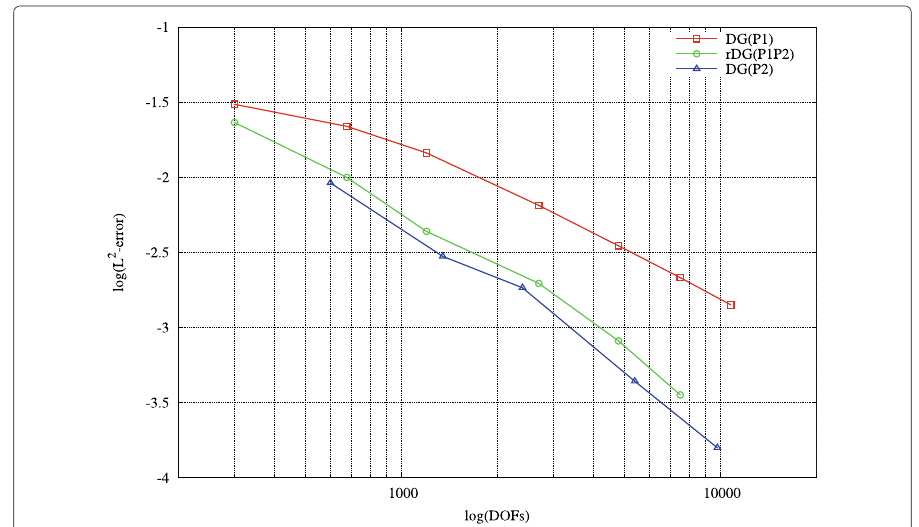
Fig. 6 Degrees of freedom versus spatial error for DG(P1), rDG(P1P2) and DG(P2) discretizations of the isentropic vortex problem